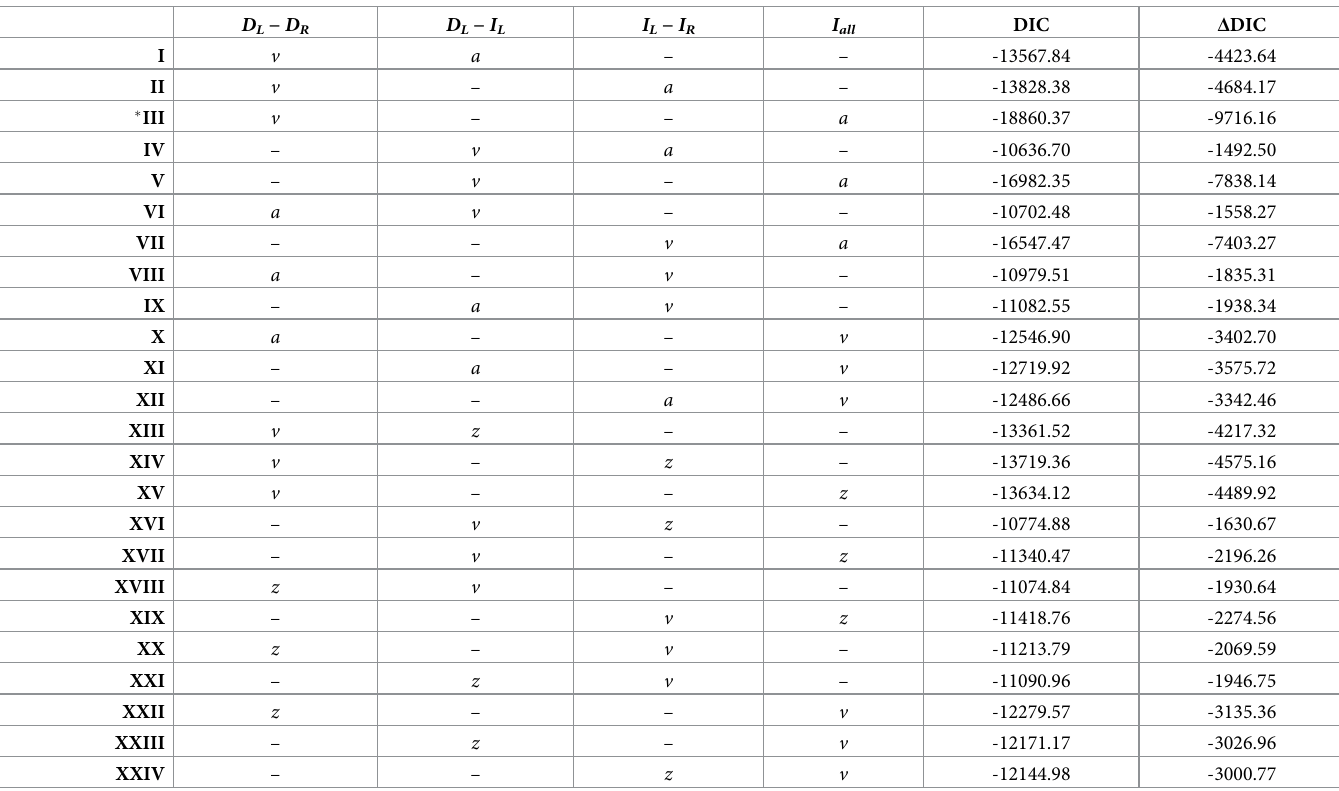
Table 2. DDM regression models and goodness-of-fit statistics. Asterisk denotes best performing model. D L − D R D L − I